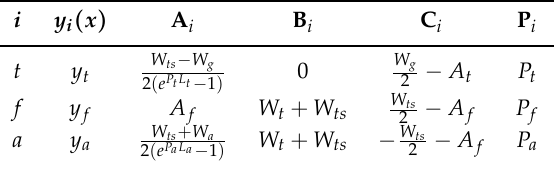
Figure 3. ( a ) The geometric design parameters of an AVA. The curves denoted by y a , y t , and y f are exponential. This transparent view of the antenna shows the curves on the front and back of the antenna ( b ) the fabricated antennas, signal side (left), and ( c ) ground side (right) [121]. Table 1. The parameters in the curve equations of the